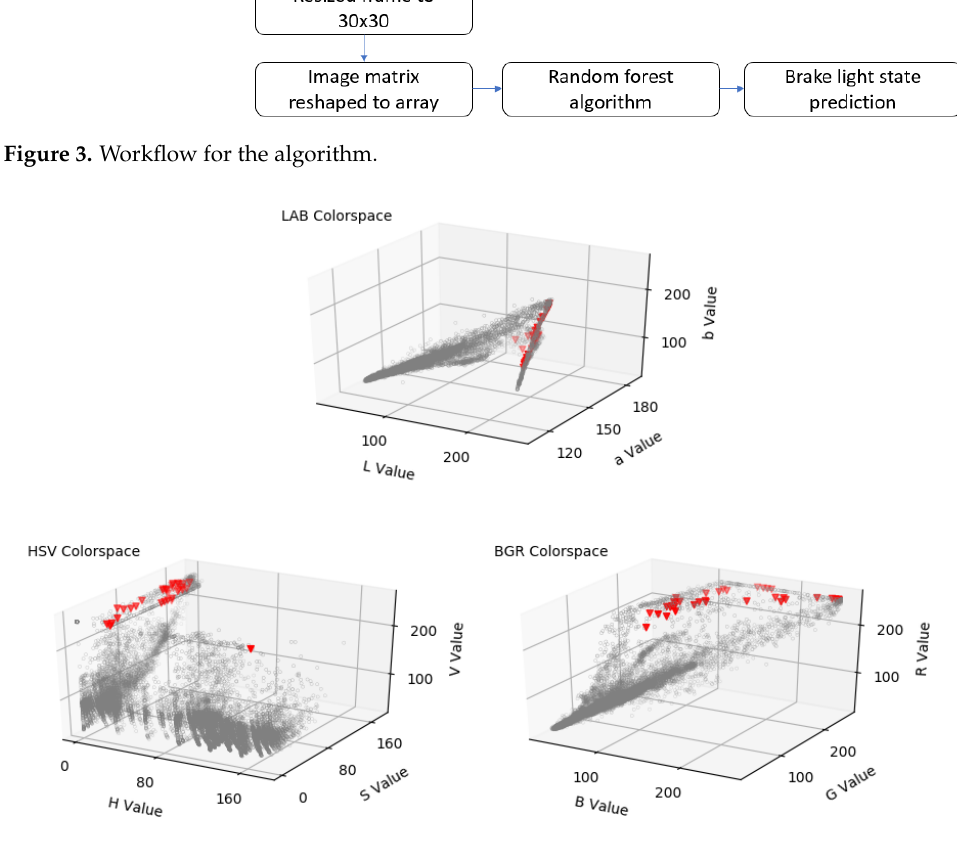
Figure 4. Scatter plot represents individual pixel values in LAB, HSV, and BGR colorspaces. Red triangles represent the brake light color values when lit, and gray circles represent full image value dis-